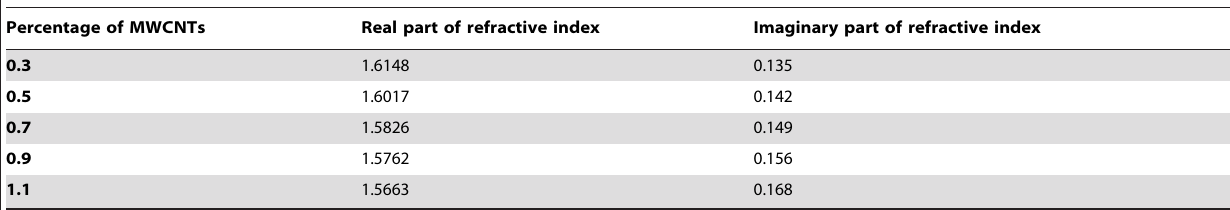
Table 1. Pertinent parameters of PPY-MWCNTs layer.